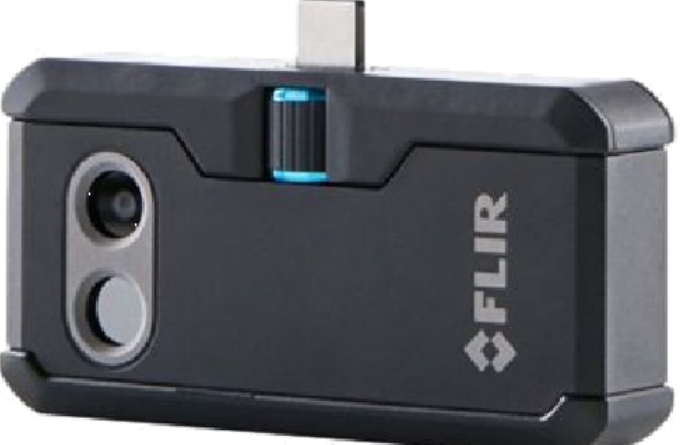
Figure 3. FLIRONE pro thermal